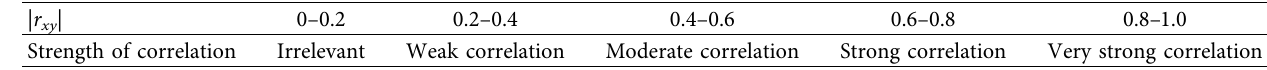
xy | and strength of correlation.